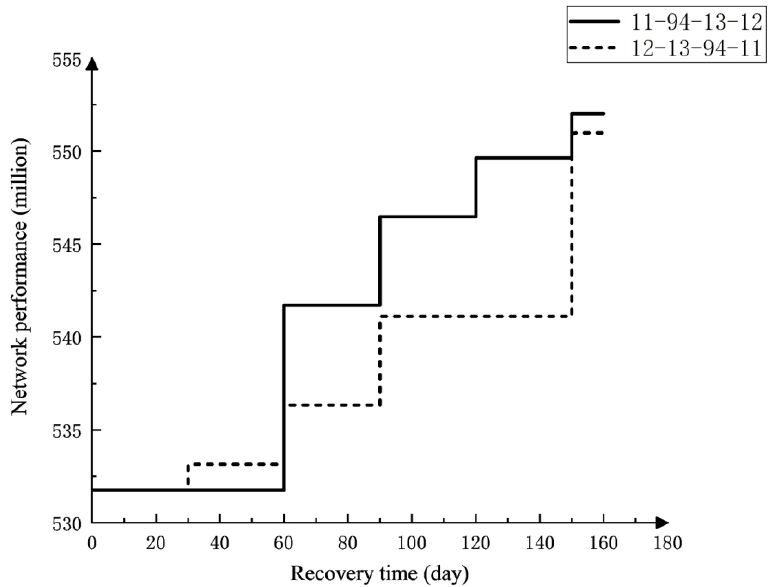
Figure 11. Network performance variation with different maintenance orders.